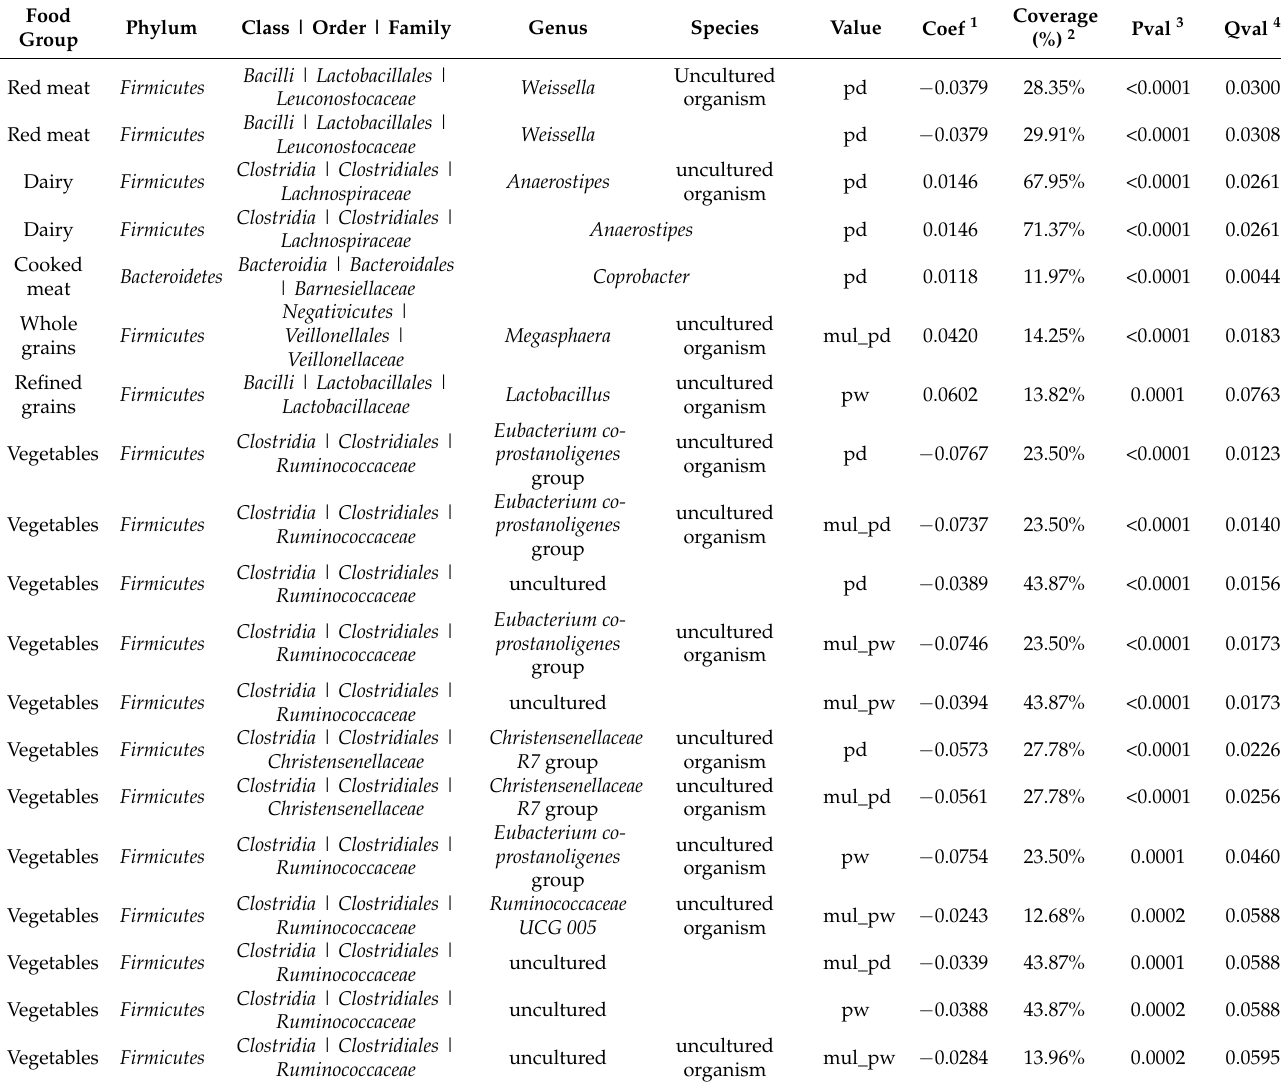
Table 3. Associations between food intakes, posteriori dietary patterns, and gut microbial profiles using